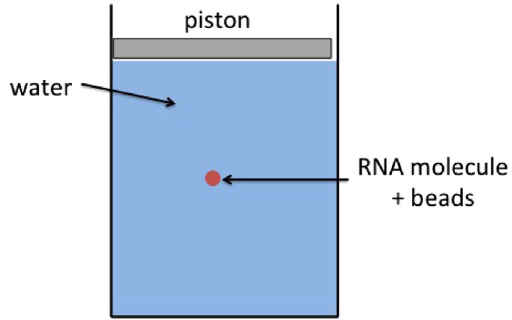
FIG. 2. Isothermal-isobaric setup for the RNA molecule in aqueous solution. The container is closed off by a frictionless piston whose vertical height h is treated as one of the many ( ∼ 10 23 ) degrees of freedom of the environment E